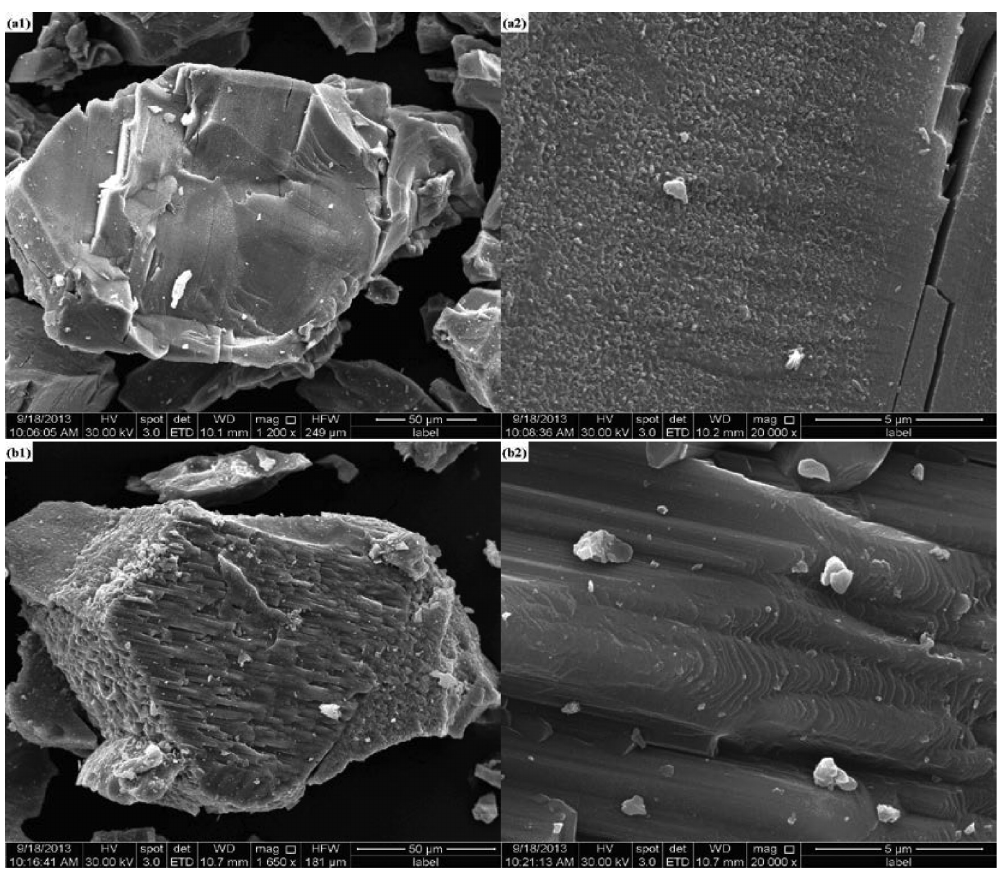
Fig. 7: SEM images of microwave roasted product: (a1) 773 K roasted 1200 × ; (a2) 773 K roasted 20000 × ; (b1) 1223 K roasted 1650 × ; (b1) 1223 K roasted 20000